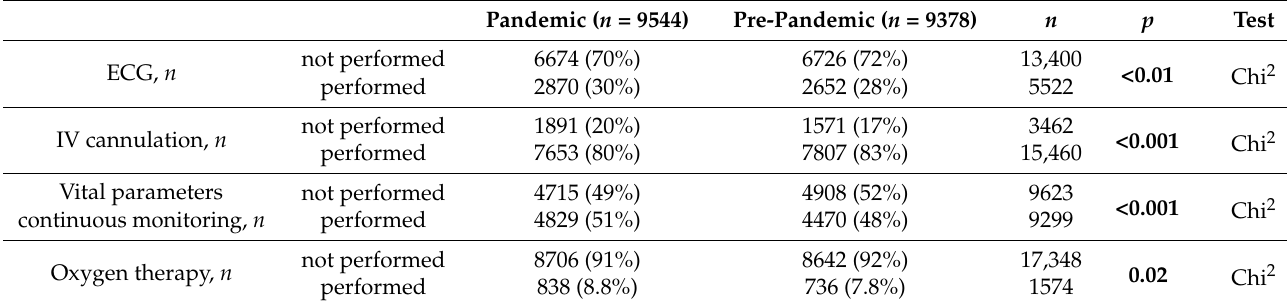
Table 3. Emergency procedures.